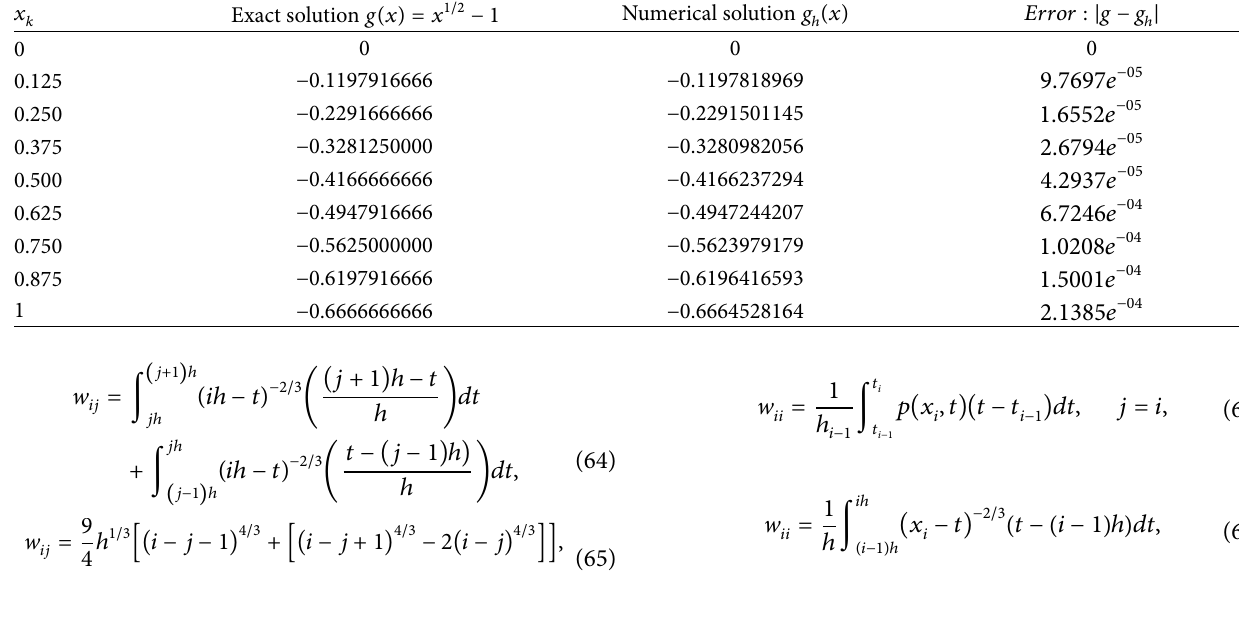
Figure 3: A comparison and absolute error between exact and numerical solutions in Example 2 with 𝑁 = 64 . (a) A comparison. (b) Absolute error. Table 5: The exact and numerical solutions using the product integration method with 𝑁 = 64